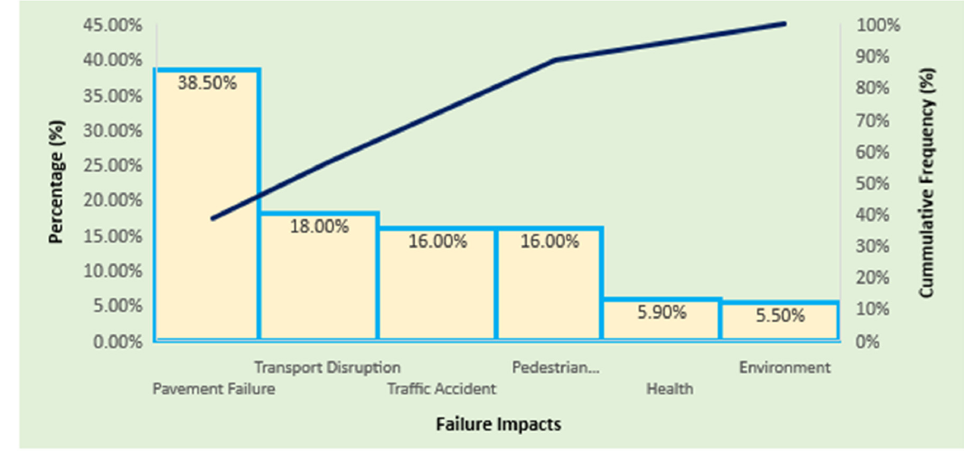
Figure 10. Drainage failure impacts individual percentages and their cumulative frequency.